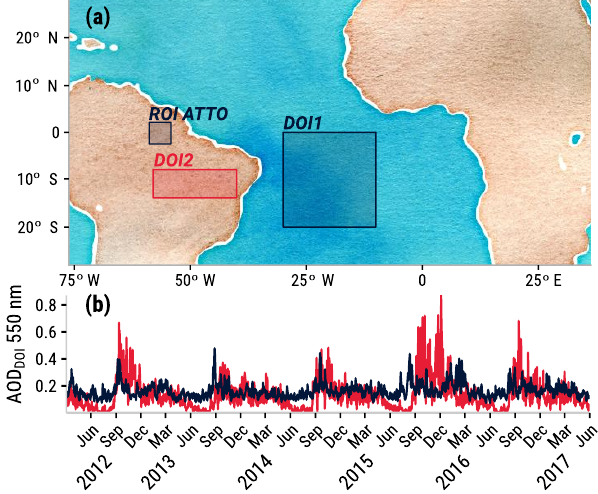
Figure 2. Aerosol optical depth (550nm) observations in two dif- ferent domains of interest shown in (a) DOI1 (boundaries: 30 ◦ W; 20 ◦ S; 10 ◦ W; 0 ◦ S) and DOI2 (boundaries: 58 ◦ W; 14 ◦ S; 40 ◦ W; 8 ◦ S). Time series of area-averaged AOD are shown in (b) for DOI1 (dark blue) and DOI2 (red). As a reference, the ATTO region of interest (ROI ATTO) is shown as a black rectangle in (a) .